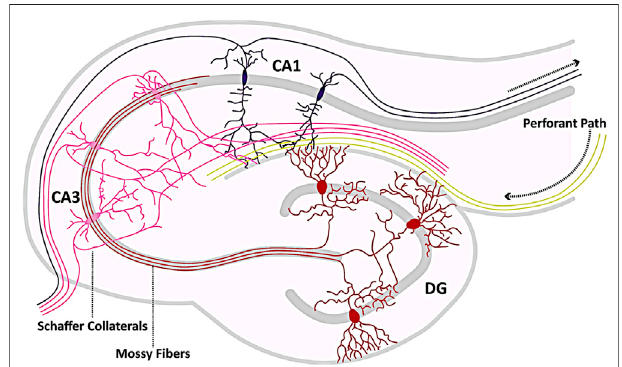
FIGURE1| Hippocampalcircuitry.Shownisaschematicrepresentation of the hippocampal circuitry (tri-synaptic circuit). The hippocampus receives afferentsfrom theneighboringentorhinalcortex, whichenterthehippocampal formation primarily via the Perforant Path (yellow) and form synaptic contactswithbothpyramidal cells(pink,purple) andpartiallywithgranulecells (GCs, red). The axons of the GCs (mossy fi bers) innervate the pyramidal cells of the CA3 region (pink), from whose axons the Schaffer collaterals branch to form synapseswiththedendrites oftheCA1 pyramidalcells(purple).Axonsof the pyramidal cells (pink, purple) eventually exit the hippocampus as efferent elements. The template for this fi gure was (Marín-Padilla, 1998; Twible et al.,